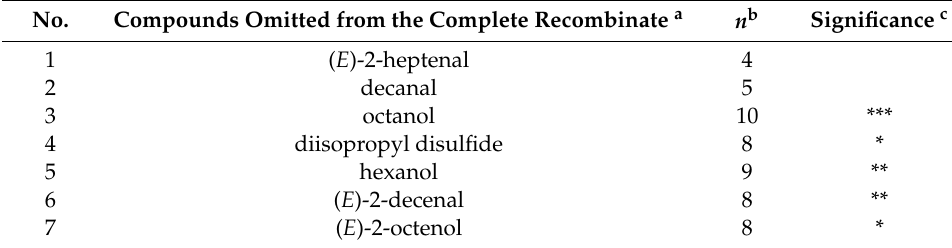
Table 5. Omission experiments from complete